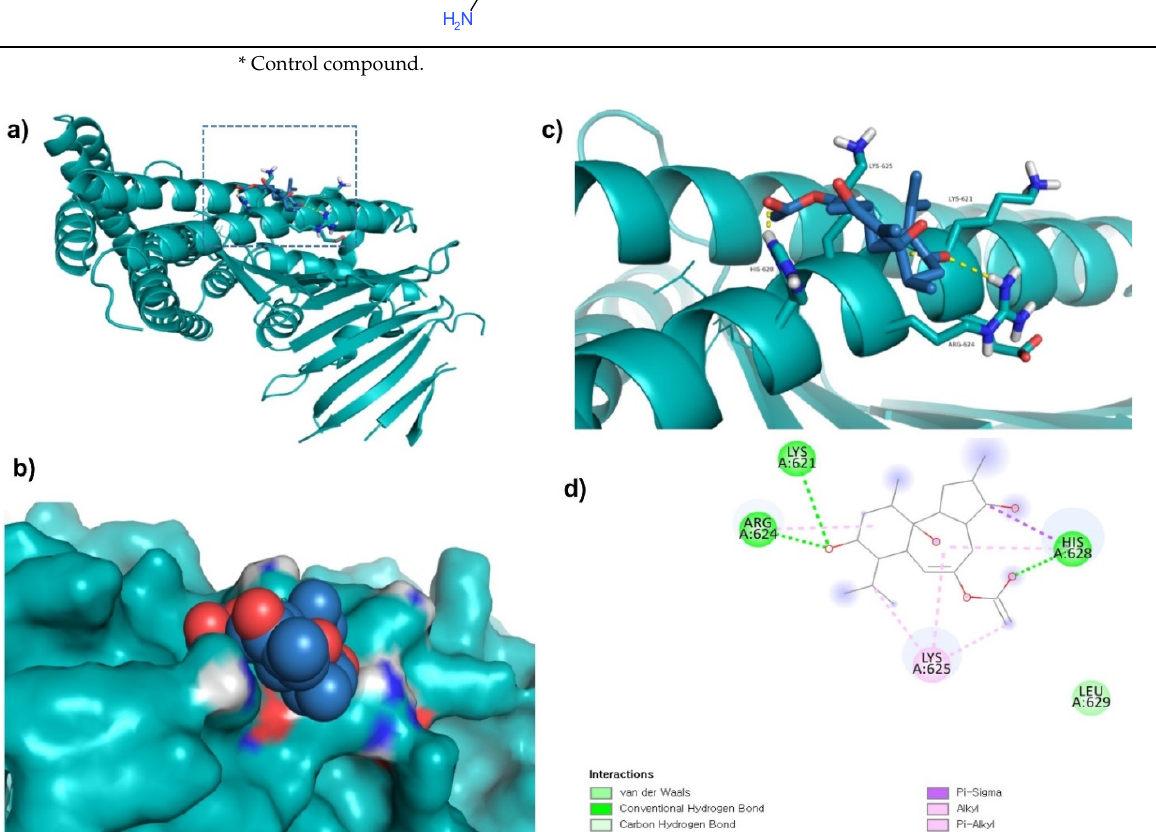
Figure 3. Visualization and surface view of ZINC164387 in active site of CagA protein ( a , b ). Three- dimensional ( c ) and 2D ( d ) view of CagA residue interacting with ZINC164387.